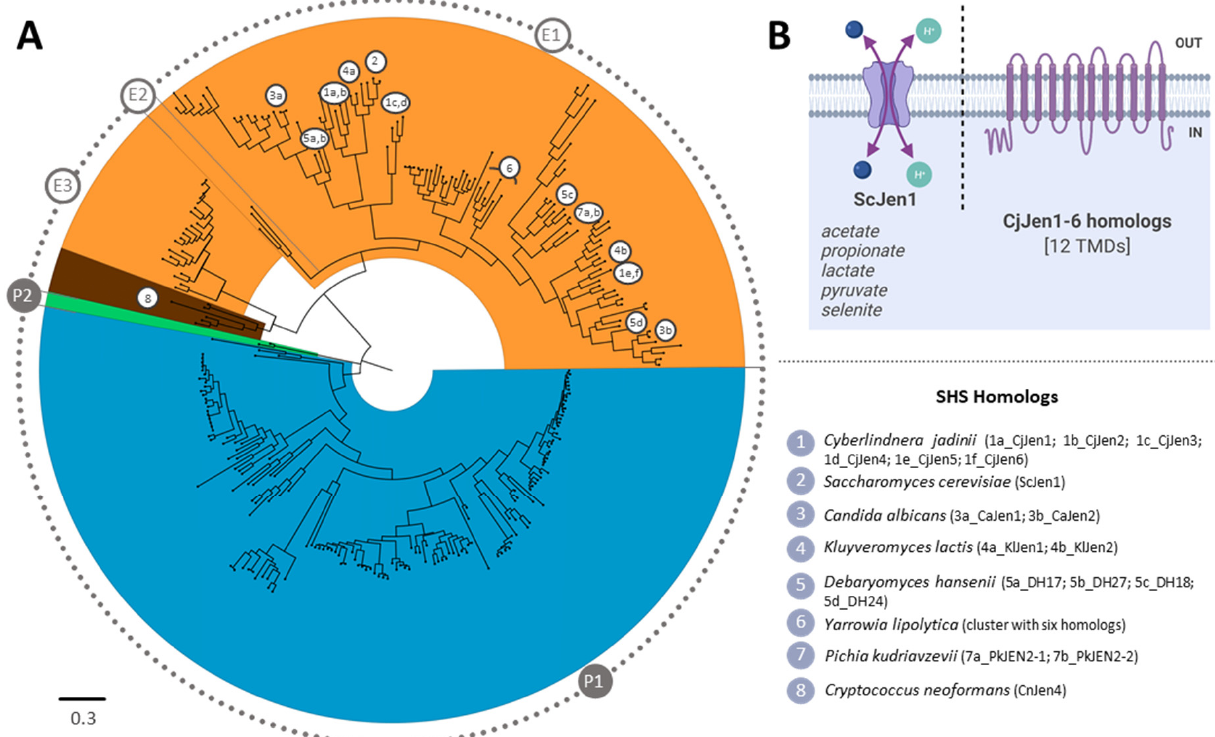
Figure 9. Maximum likelihood phylogenetic tree of SSS (SLC5 homolog) family members (TCDB 2.A.21). ( A ) Branch lengths are proportional to sequence divergence. Groups indicated as E1, E2,